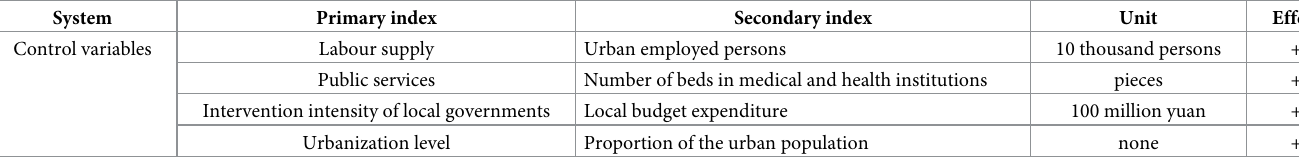
Table 4. Indicator system for control